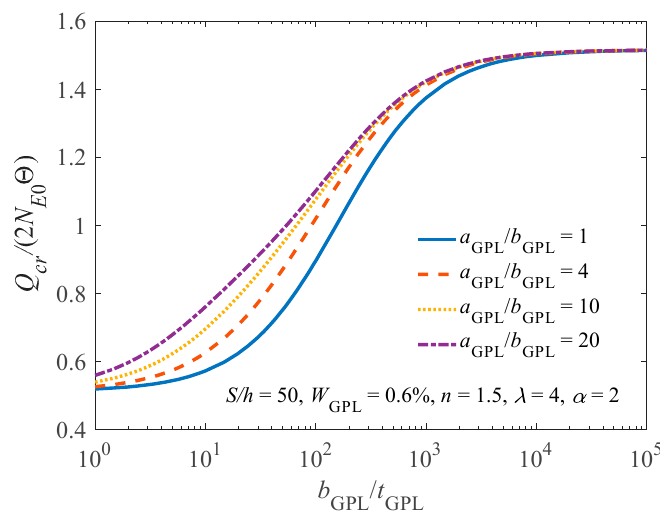
graphene platelets (GPLs).